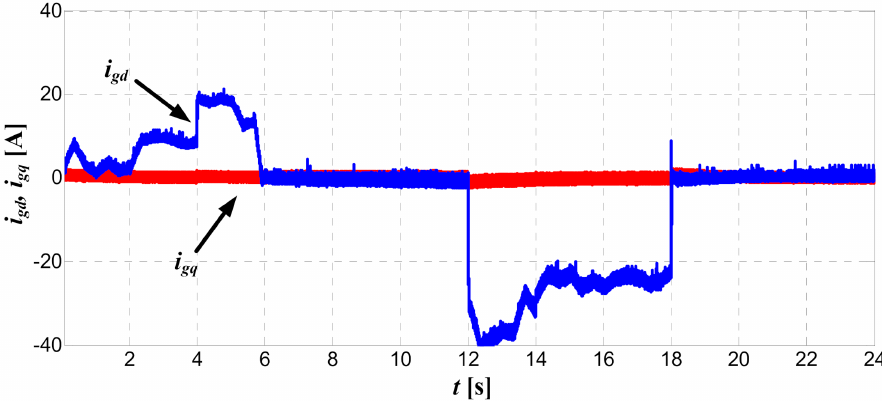
Figure 22. Waveforms of components i gd , i gq of grid current vector.